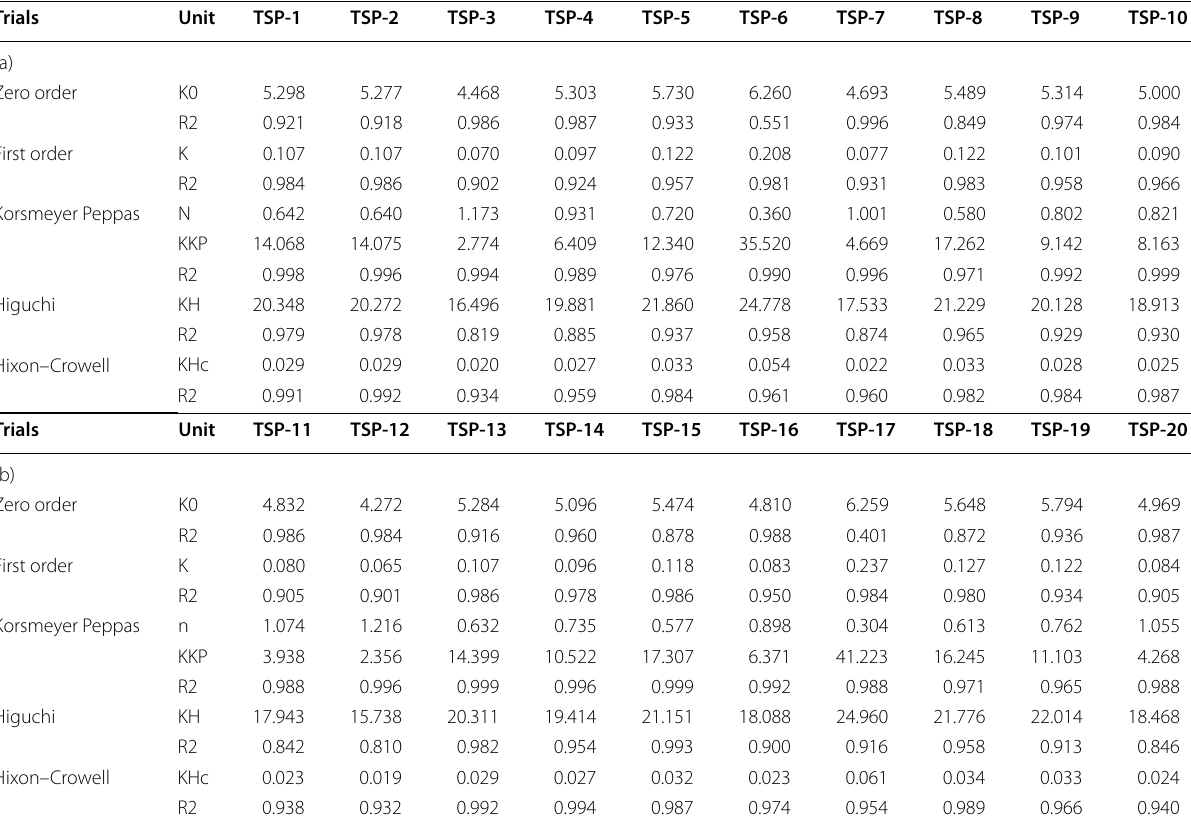
Table 9 (a) Release kinetics of DOE batches TSP-1 to TSP-10, (b) release kinetics of DOE batches TSP-11 to TSP-20